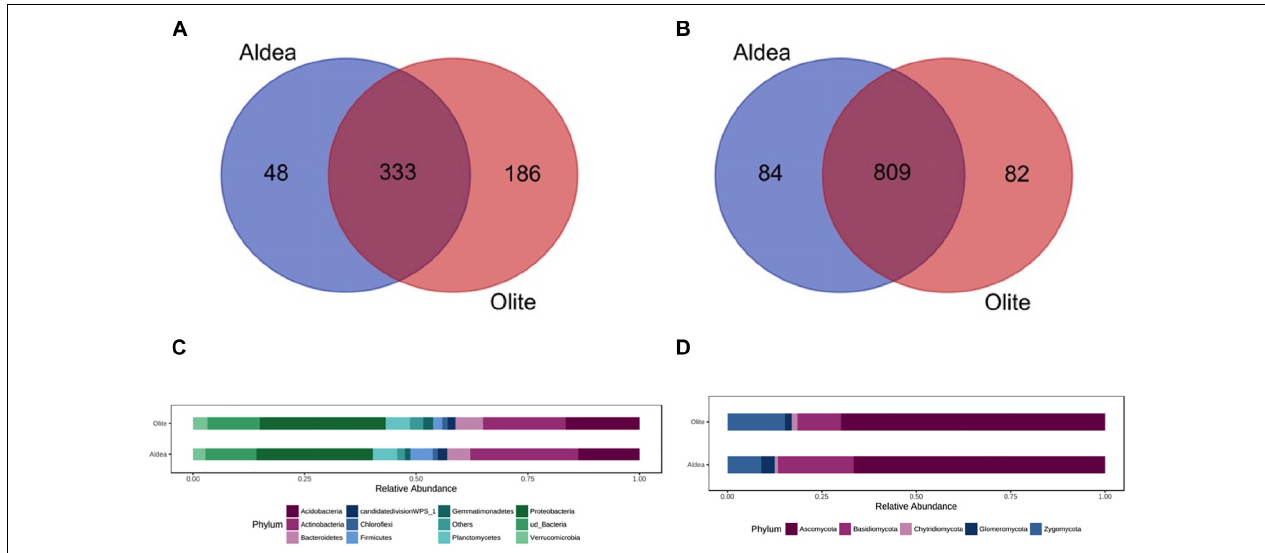
FIGURE 1 | Venn diagram illustrating the overlap of the OTUs identified in the bacterial (A) and fungal (B) microbiota between vineyards. Relative abundance of different bacterial (C) and fungal (D) phyla in the rootstock rhizospheres in both vineyards representing OTUs showing more than 1% relative abundance of all reads and present in at least 2/3 of replicates. Phyla representing less than 1% of the total reads are grouped in “Others”.